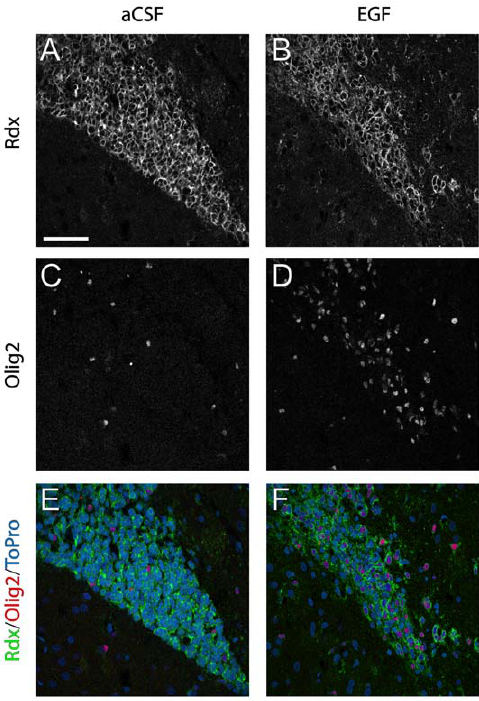
Figure 6. Radixin and Olig2 expression in the rostral migratory stream. Immunofluorescence staining illustrating radixin (Rdx) and Olig2 expression in coronal sections of the rostral migratory stream (RMS) after 7 days of aCSF or EGF infusion. ( A, B ) color separation for radixin, ( C, D ) color separation for Olig2, ( E, F ) color composite images of radixin (green), Olig2 (red) and the nuclear counterstain ToPro3 (blue). A notable increase in Olig2 positive cells is visible under EGF stimulation ( D ) compared to aCSF ( C ). The increased population of Olig2 positive cells expresses radixin ( F ). Scale bar in A=50 m m.